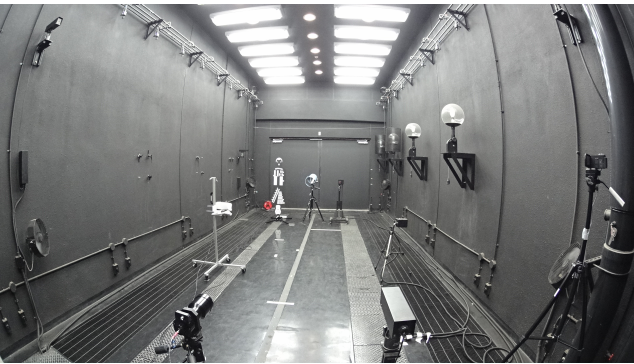
Figure 2. Spectral transmission measurement devices in the fog chamber.